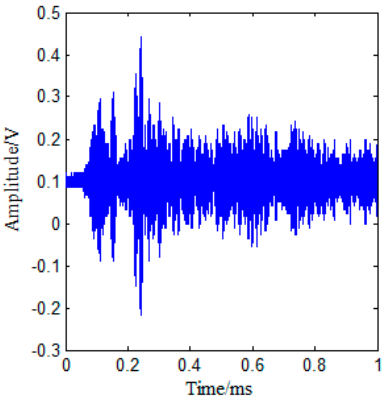
Figure 8. Recorded signal with environmental noise.